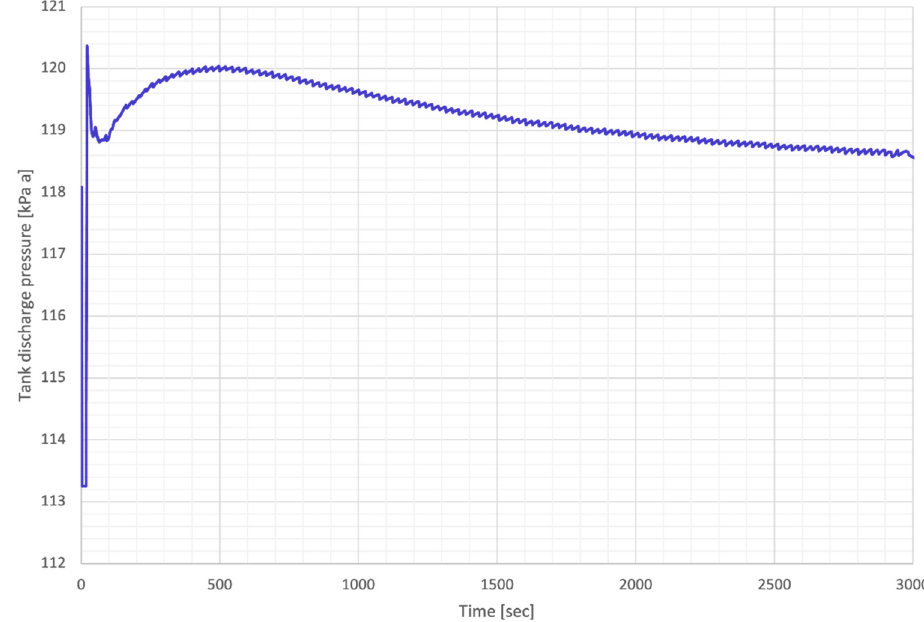
Figure 15. Tank discharge pressure.